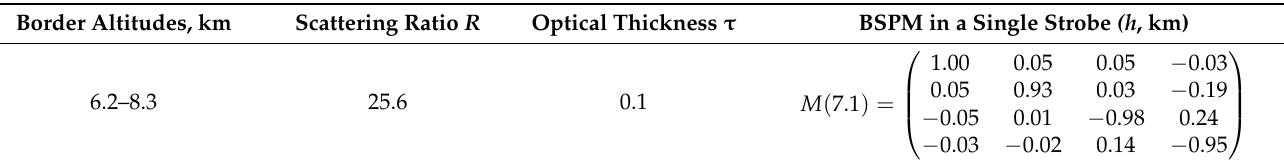
Table 1. Geometric and optical characteristics of the cloud registered in lidar measurements (6 January 2021; series of measurements was performed from 2:34 to 2:51 p.m.).